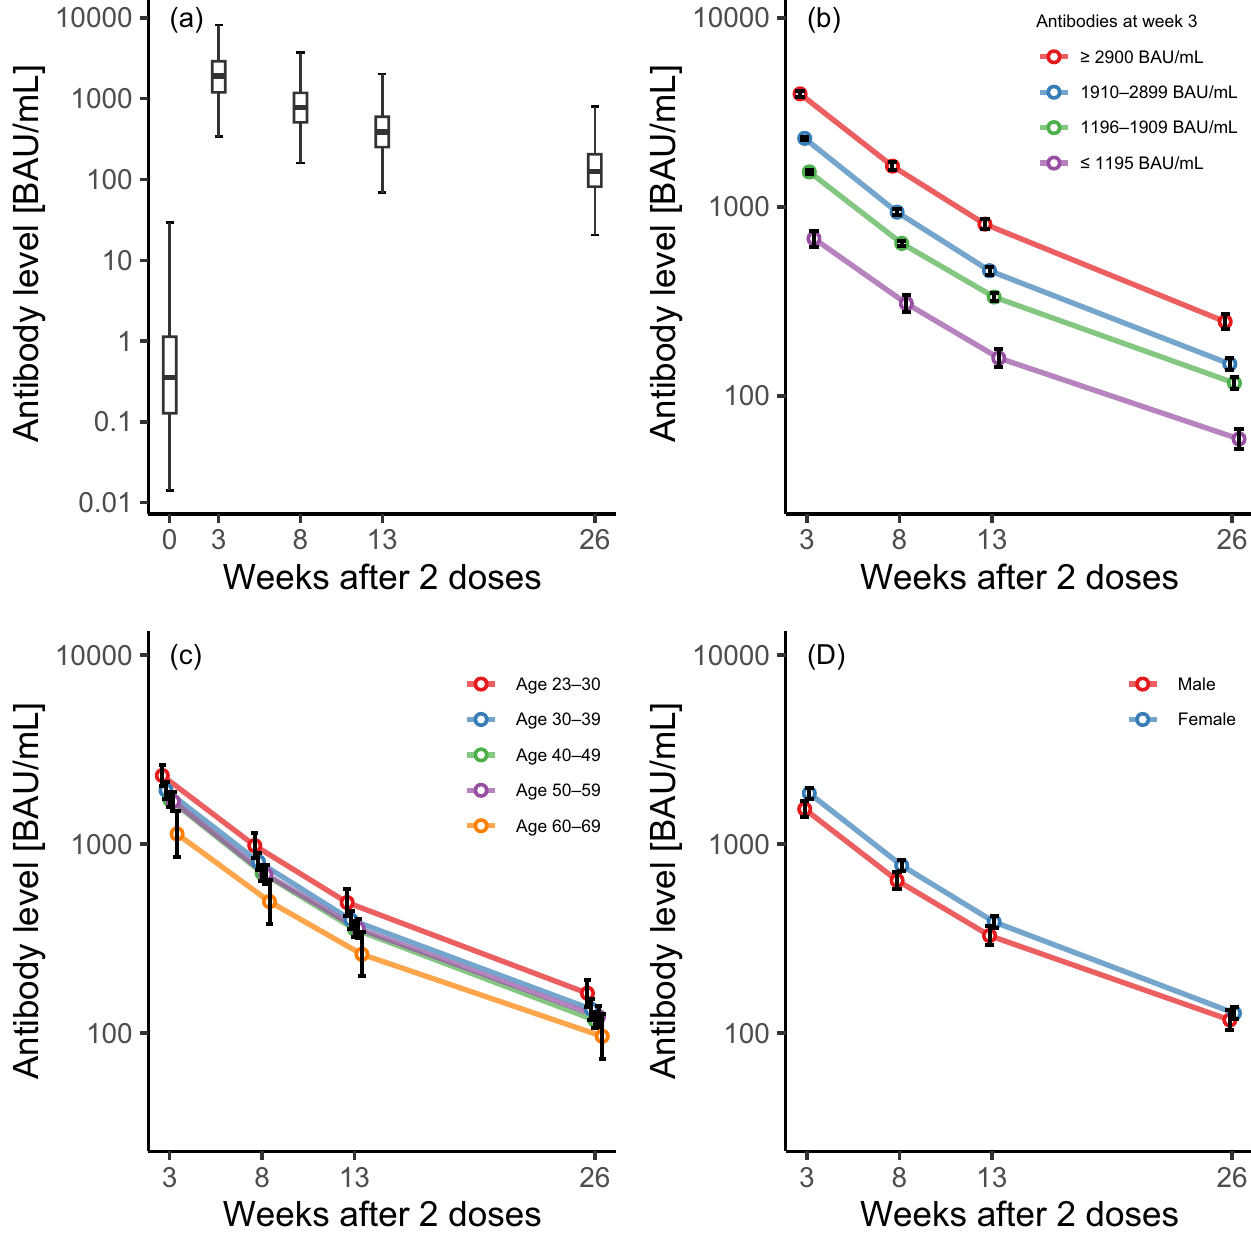
Fig. 1 Semi-logarithmic plots of SARS-CoV-2 spike antibodies after two doses of BNT162b2 vaccine. a Box plots of all available cases ( N = 657; cases for which data were available only at week zero were excluded); logarithmic means strati fi ed by b antibodies at week 3, c age group, and d sex. Error bars indicate 95% con fi dence intervals. b The cutoffs for antibodies at week 3 were determined based on the 25th, 50th, and 75th percentiles. All the demonstrated antibody titers were anti-receptor-binding domain